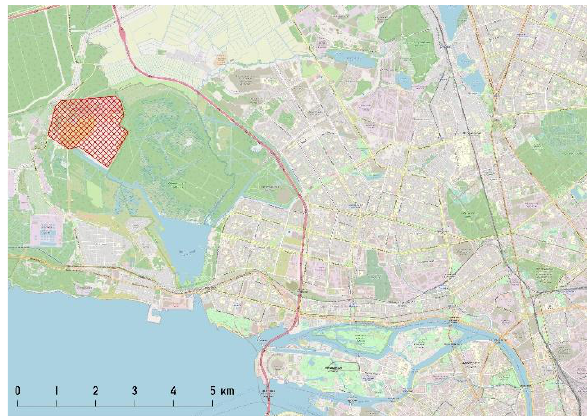
Figure 1 . Location of the Yuntolovo microdistrict (red hatched area). Islands to the southeast are the central area of St.